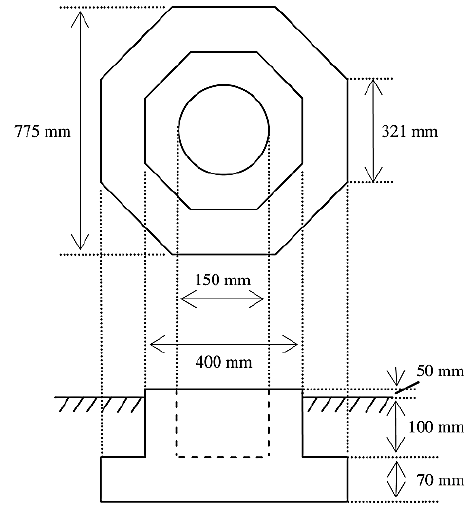
Figure 16. View of the grounding grid under study.